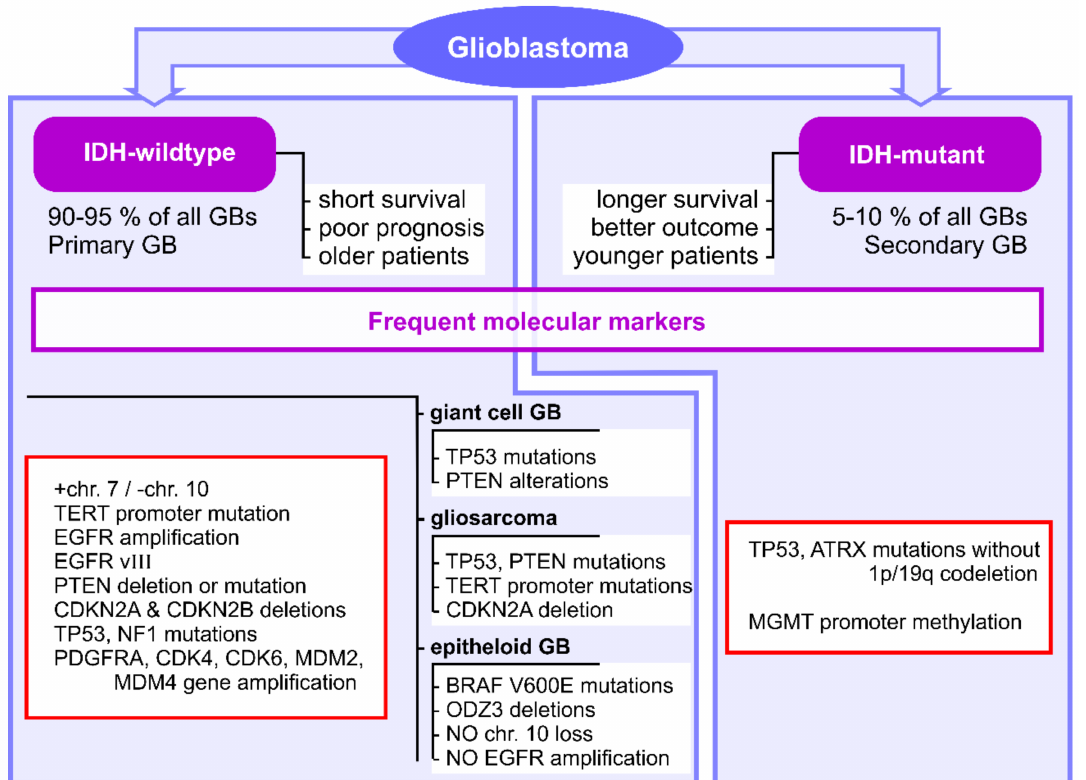
Figure 1. Frequent molecular markers identified for GB clinical subtypes. IDH1, isocitrate dehydrogenase 1; GB, glioblas- toma; TERT, telomerase reverse transcriptase; EGFR, epidermal growth factor receptor; PTEN, phosphatase and tensin homolog; CDKN2A, cyclin-dependent kinase inhibitor 2A; CDKN2B, cyclin-dependent kinase inhibitor 2B; NF1, neurofi- bromin 1; PDGFRA, platelet-derived growth factor receptor A; CDK4, cyclin-dependent kinase 4; CDK6, cyclin-dependent kinase 6; MDM2, mouse double minute 2 homolog; MDM4, mouse double minute 4 homolog; MGMT, O6-alkylguanine DNA